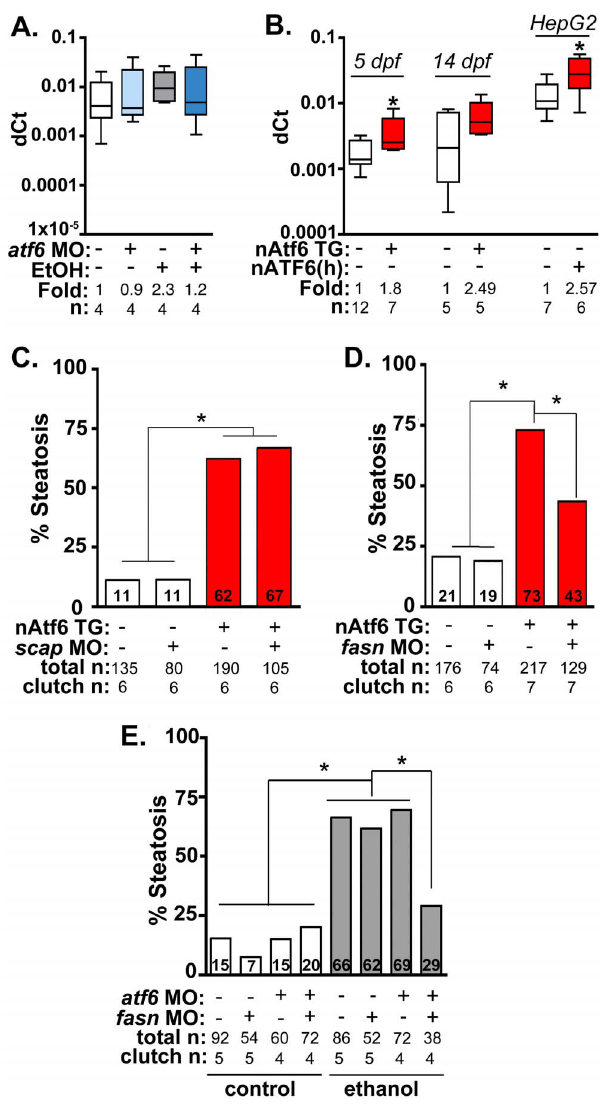
Figure 5. Fasn functions downstream of Atf6 to cause steatosis independent of Srebp activation. A: qPCR analysis of fasn expression in atf6 morphants and uninjected larvae treated with EtOH for 32 hours. B: qPCR analysis of fasn expression in nAtf6 TG larvae and HepG2 cells transfected with nATF6. Statistics: unpaired t-test. *, p , 0.05. C: Quantification of whole mount oil red O staining of nAtf6 TG larvae injected with scap MO. ‘‘Total n’’ and ‘‘clutch n’’ corresponds to the number of larvae and number of clutches scored, respectively. Statistics: chi-square with Fisher’s Exact Test. *, p , 0.05. D: Quantifica- tion of oil red O staining in nAtf6 TG larvae injected with fasn MO. E: Quantification of oil red O staining in atf6/fasn double morphants treated with 350 mM EtOH for 24 hours. Statistics: chi-square with Fisher’s Exact Test. *, p , 0.05.